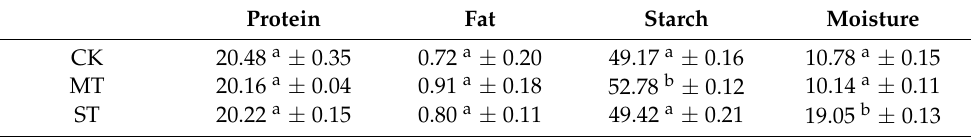
Table 5. Changes of proximate composition of microwave precooked adzuki beans (Unit: g/100 g).